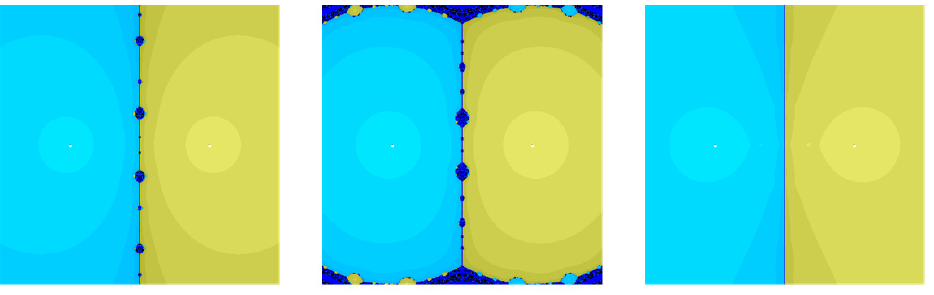
Figure 3. Attraction basins for Padé 2–1 on the left, Padé 3–1 in the middle and (14) to the